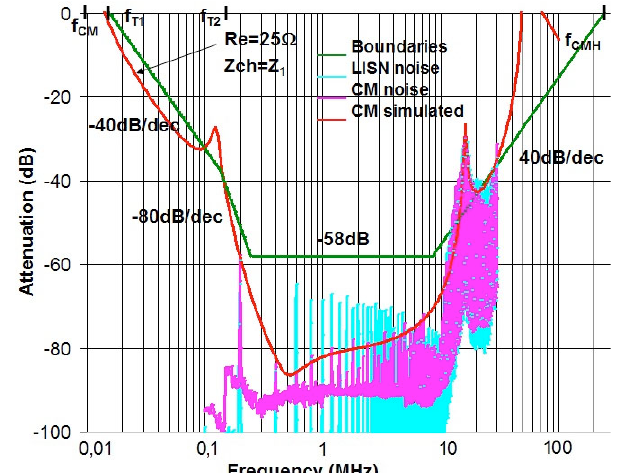
Figure 13: Comparison of the CM attenuation of the filter measured and simulation.